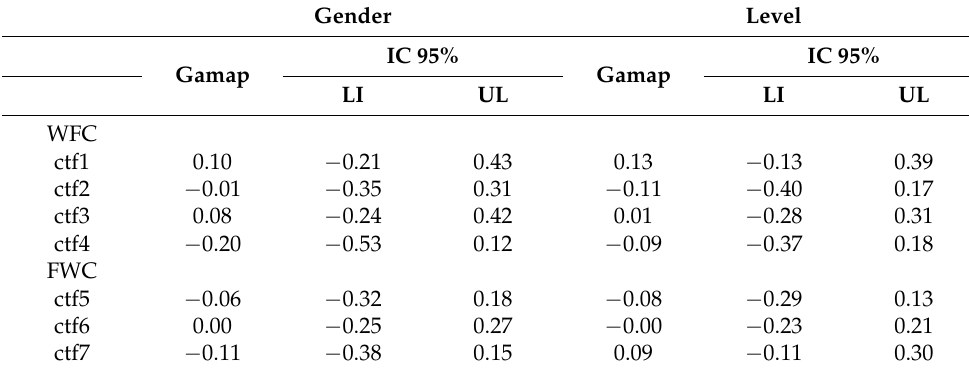
Table 5. Differential item functioning (DIF), with partial gamma